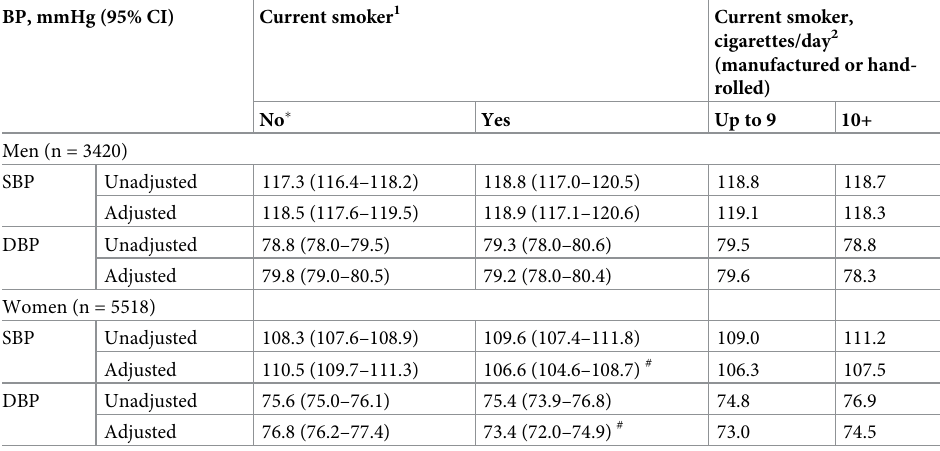
Table 3. Unadjusted and age-adjusted mean SBP and DBP by smoking